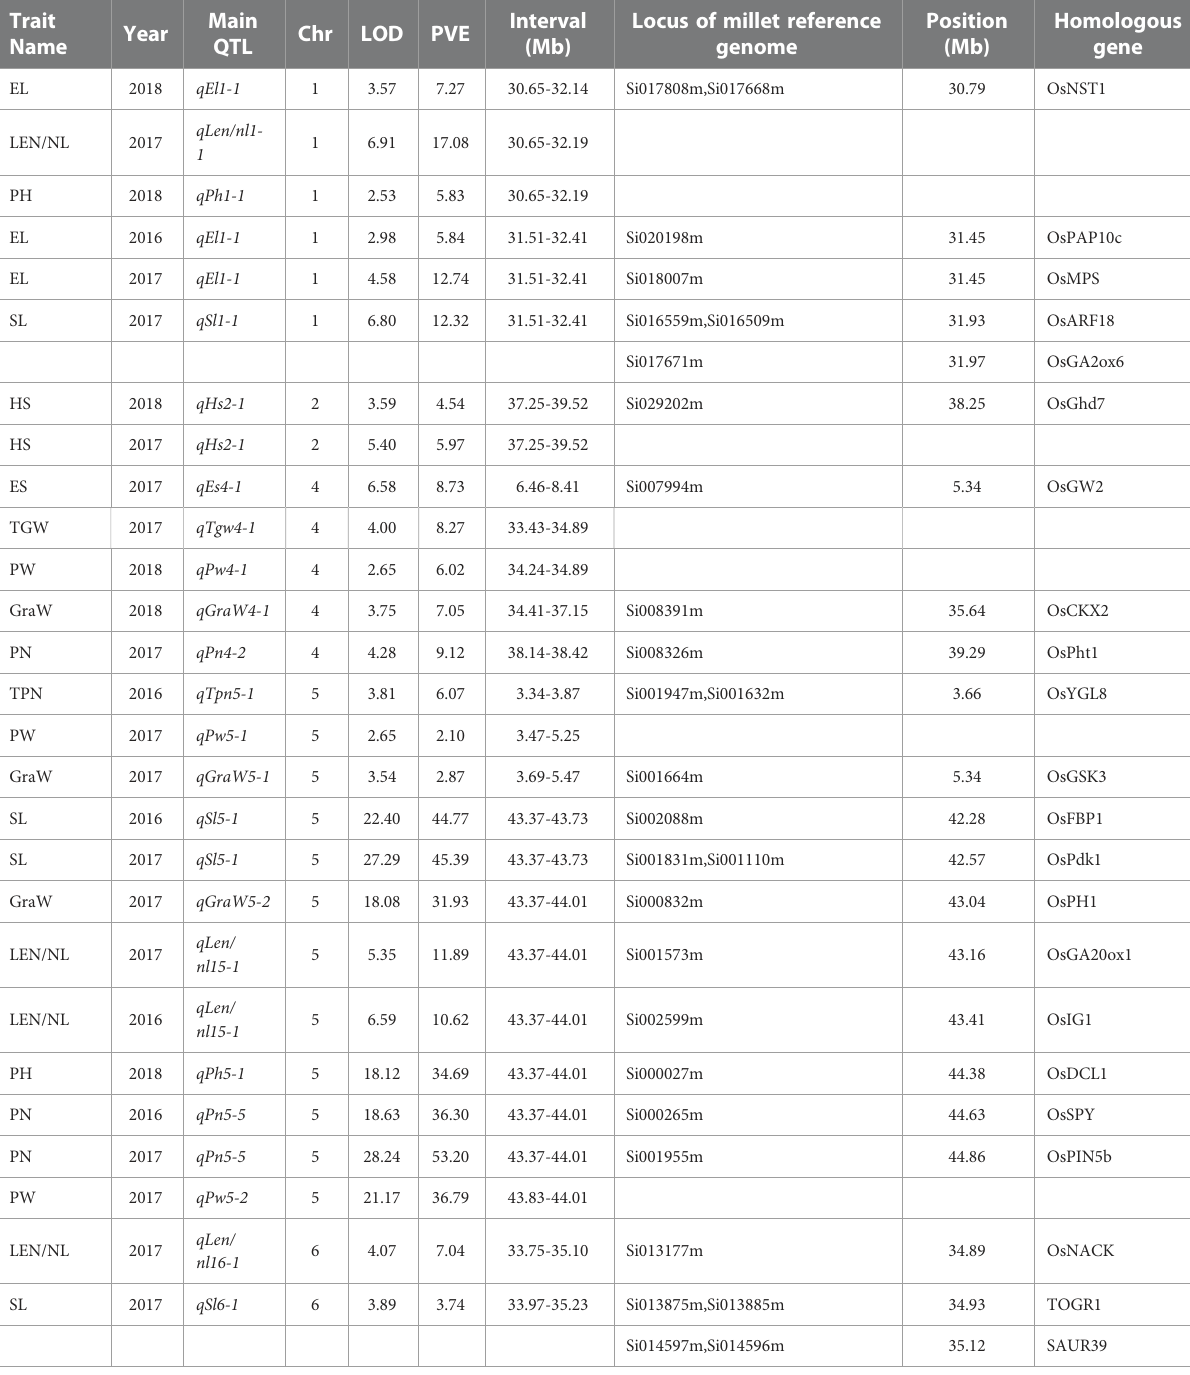
TABLE 2 Candidate genes based on pQTL